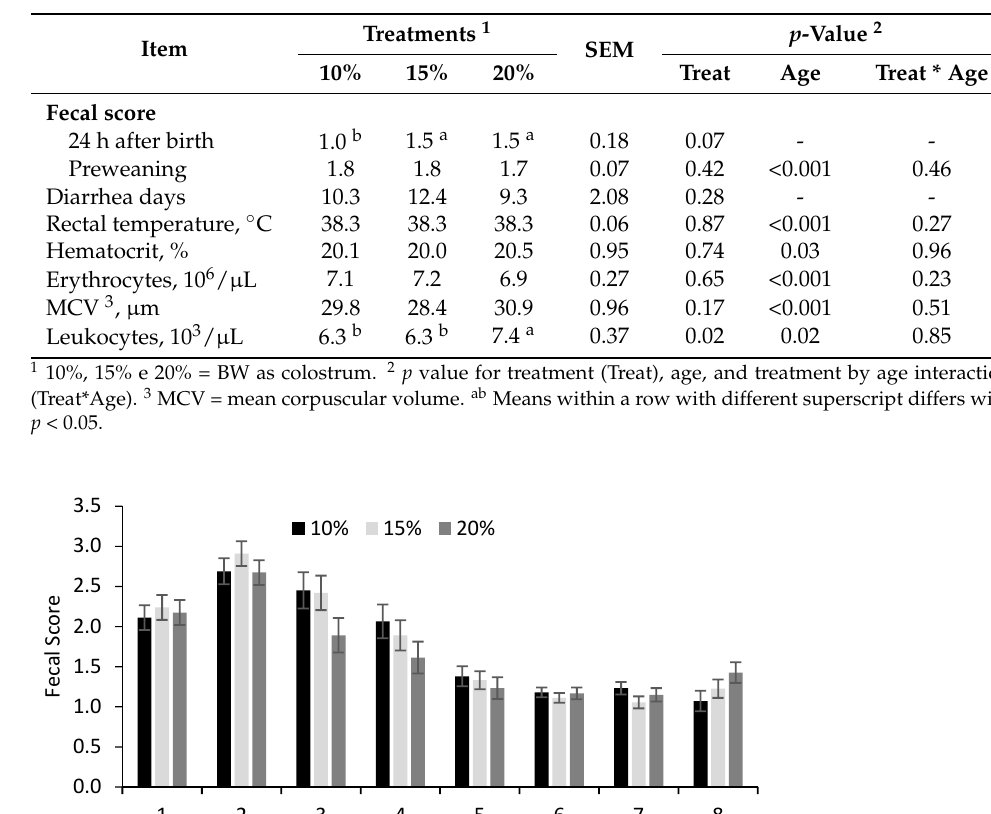
Table 4. Fecal score, diarrhea occurrence, rectal temperature, hematocrit, erythrocytes, and leukocytes of dairy calves fed different volumes of colostrum at birth.